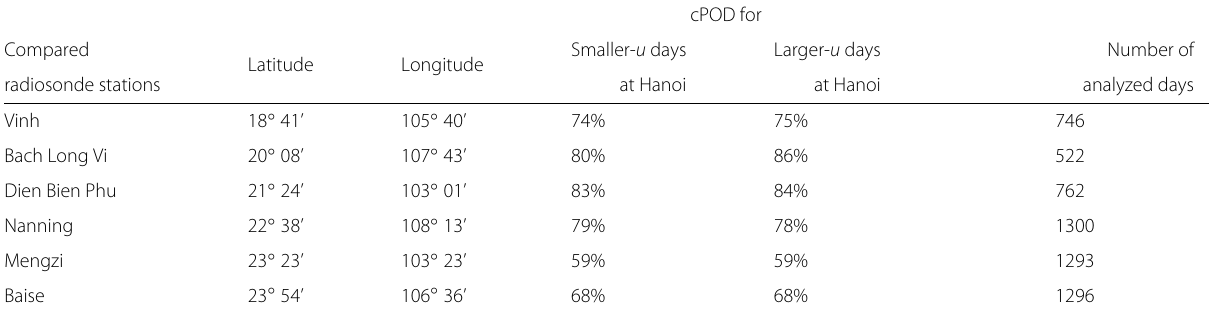
Table 2 Correspondence in zonal wind at the 850 hPa level over Hanoi to those over surrounding stations around Hanoi in heavy-rain days when rainfall is greater than 50 mm day − 1 in at least one grid point within the analyzed region shown in Fig. 1a in either VnGP or GSMaP Compared Smaller- u days Larger- u days Latitude Longitude radiosonde stations at Hanoi